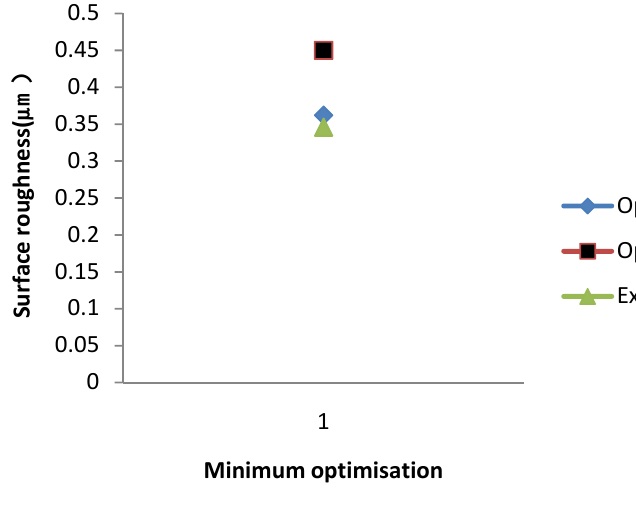
Figure 4. Comparison of minimum optimised surface roughness with experimental and